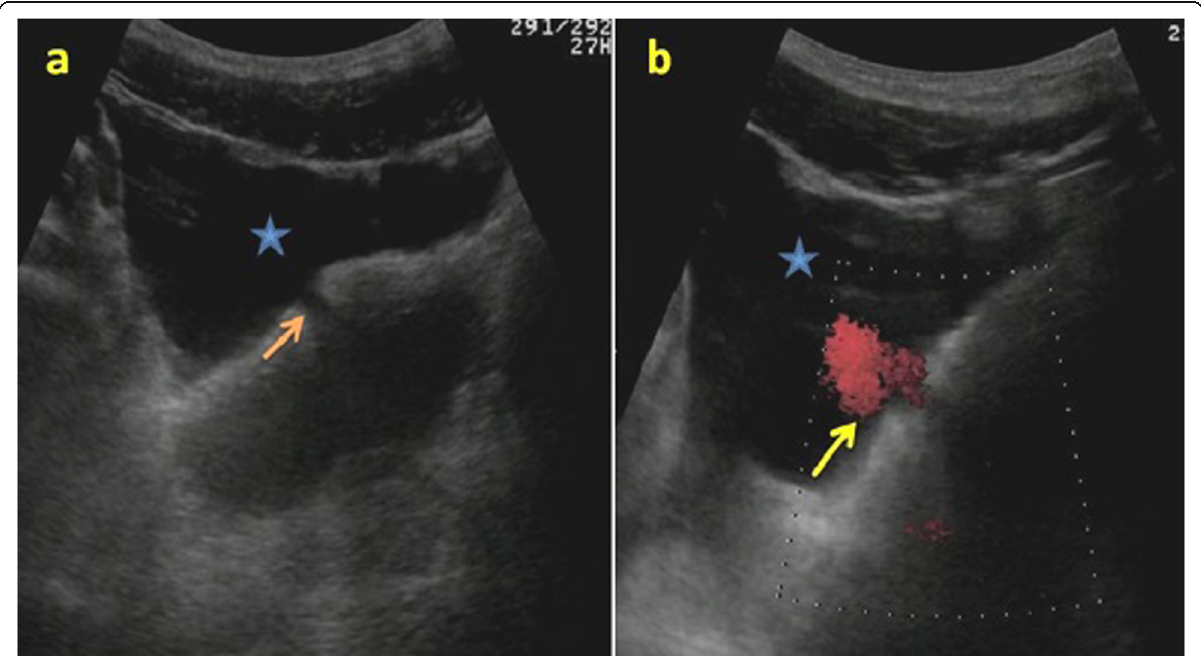
Fig. 1 Ultrasonographic images of intraperitoneal anechoic free fluid collection ( a and b ; blue star) with a rupture of the urinary bladder dome ( a ; orange arrow). In b , Doppler shows an abnormal signal, simulating a ureteral jet, but pointing from the inside to the outside of the bladder (yellow